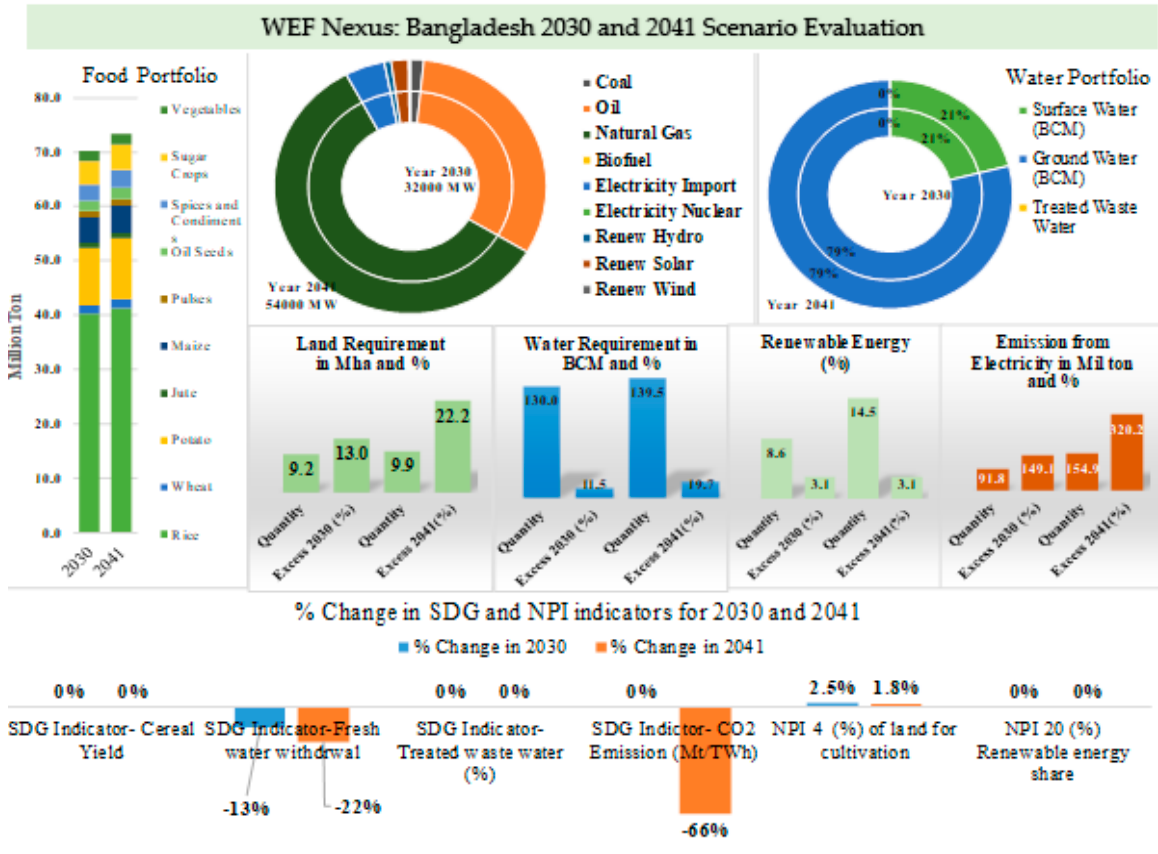
Figure 4. Assessment of resource requirements projected for year 2030 and 2041 under BAU scenario. The percentage change in SDG and NPI indicators for the BAU scenario, compared to base year 2016.